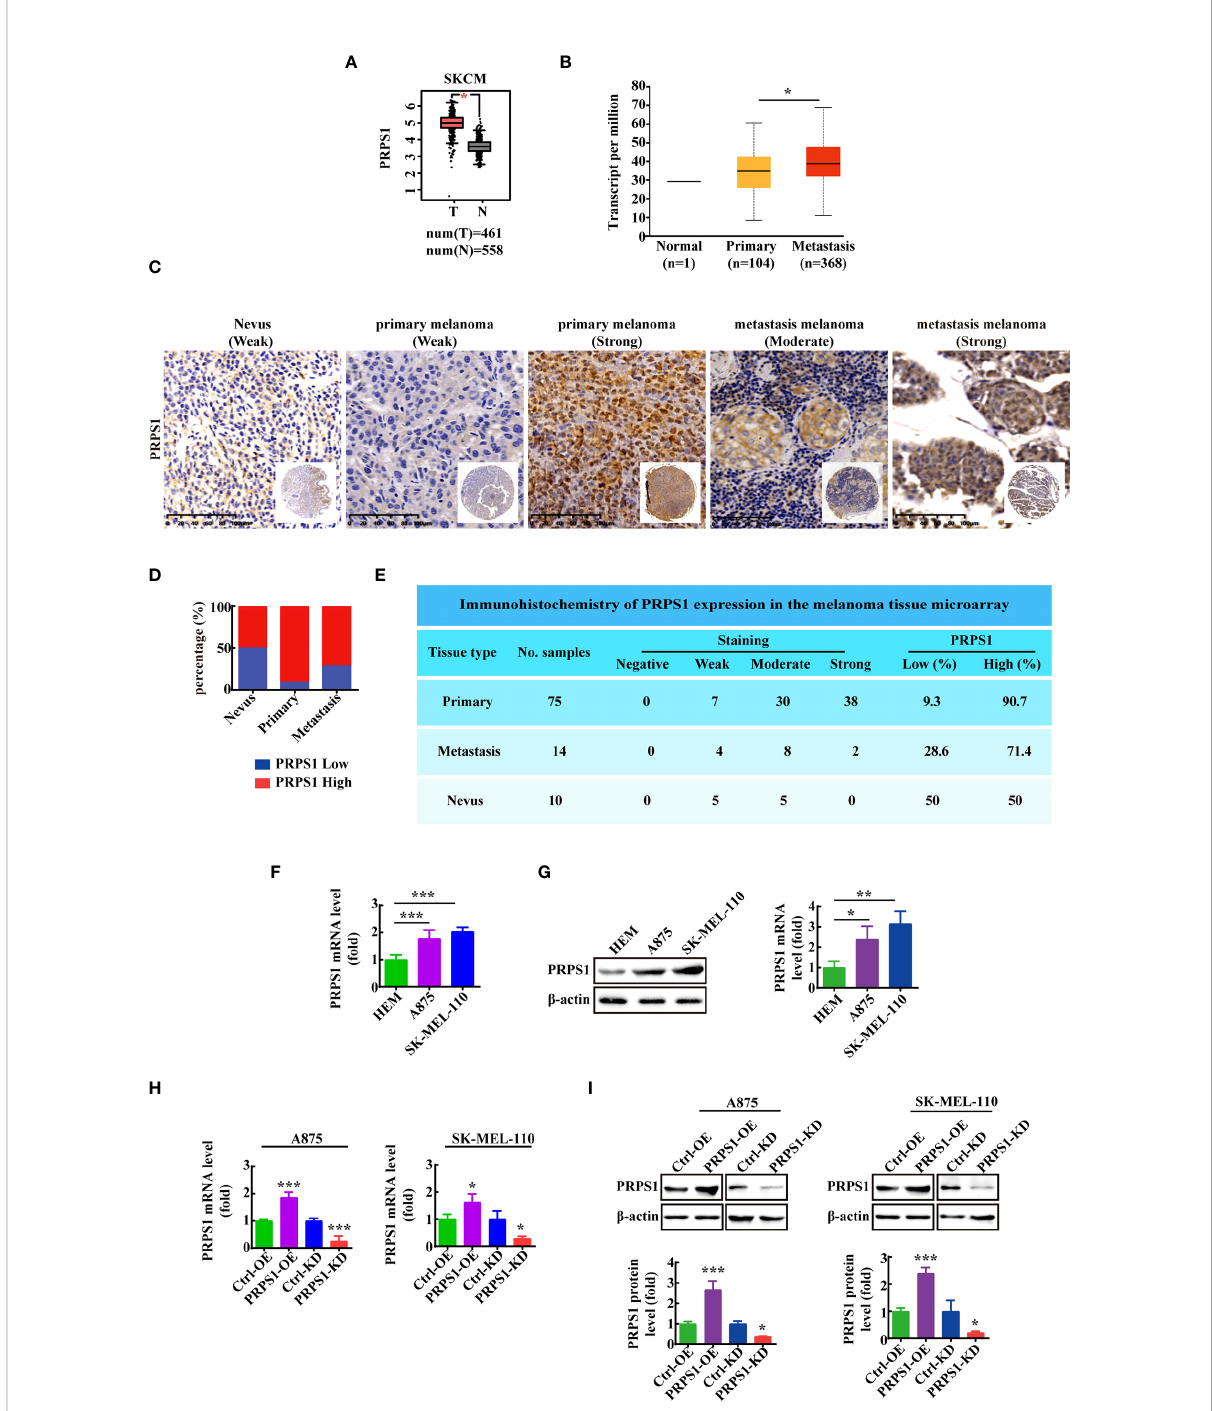
FIGURE 1 PRPS1 is highly expressed in melanoma and is related to the degree of malignancy of melanoma. (A) The expression of PRPS1 in normal tissue and melanoma tissue based on GEPIA database. (B) The expression of PRPS1 in normal tissue and primary melanoma and metastasis melanoma based on Ualcan database. (C) Representative images of PRPS1 expression in the melanoma tissue microarray are shown (200×). Scale bars=100 m m. (D) Percentage of primary melanoma and metastasis melanoma with PRPS1-Low and PRPS1-High expression. (E) Immunohistochemistry of PRPS1 expression in the melanoma tissue microarray. (F, G) The mRNA and protein expression of PRPS1 in HEM cell and melanoma cells were analyzed by qPCR (F) and western blotting analysis (G) . (H, I) The stable PRPS1 overexpression and knockdown in A875 and SK-MEL-110 cells were established. The expression of PRPS1 were measured by Q-PCR (H) and western blotting (I) analysis. The data represent three independent experiments. The data as indicated the mean ± SD and was analyzed by student ’ s t-test. * p < 0.05; ** p < 0.01; *** p <